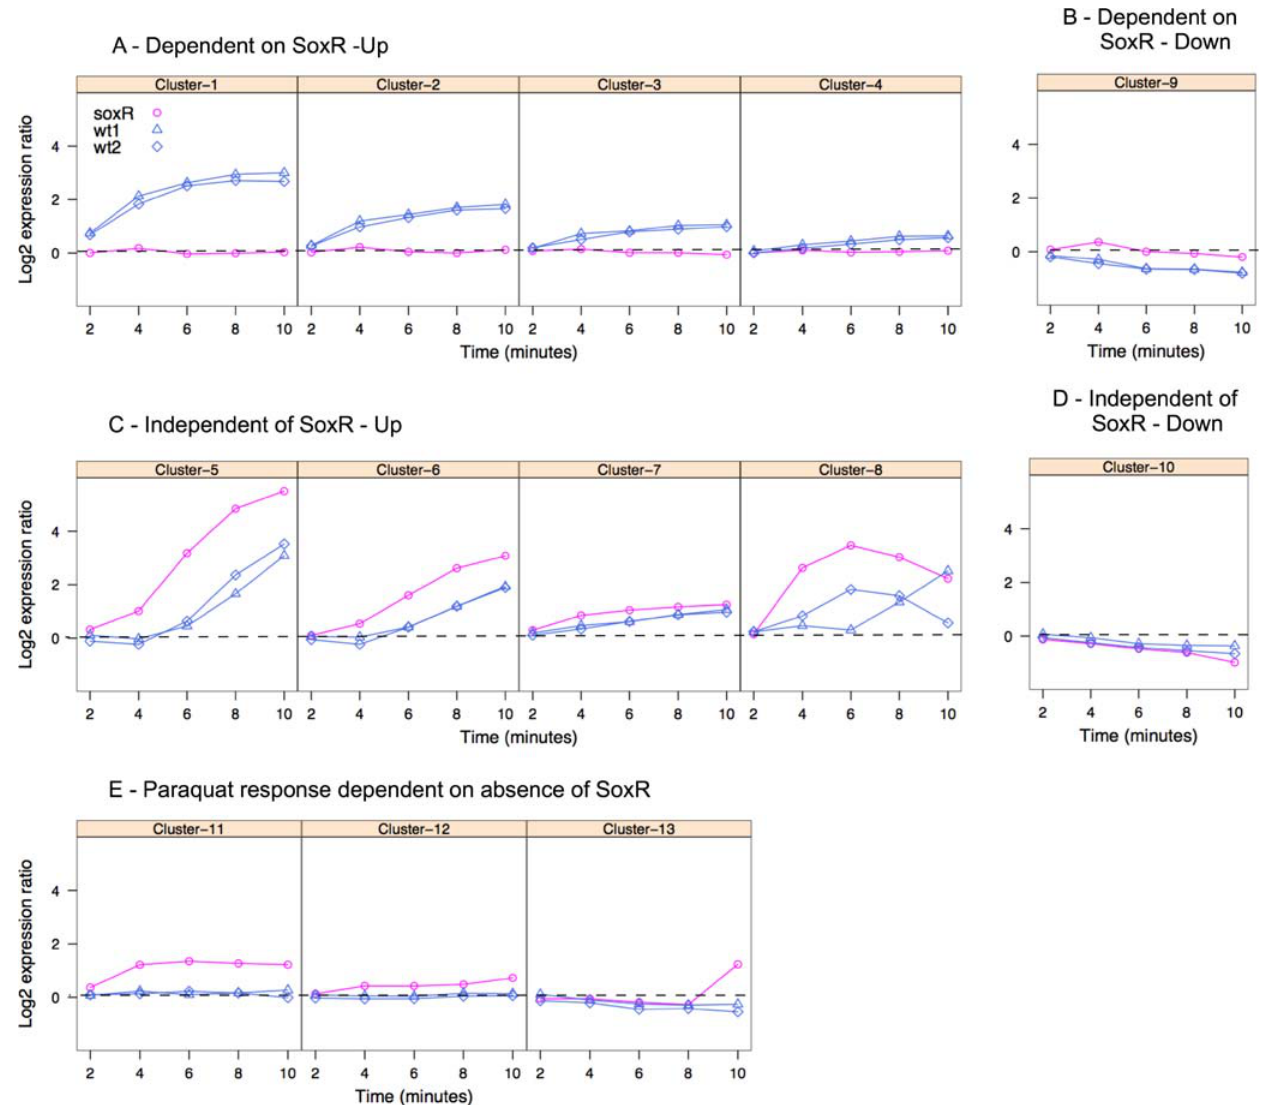
Figure 3. Major paraquat response clusters. Each graph shows average log 2 expression values as a function of time of all genes in a cluster relative to time zero. The groups are derived from K-means clustering on all three time-series experiments.